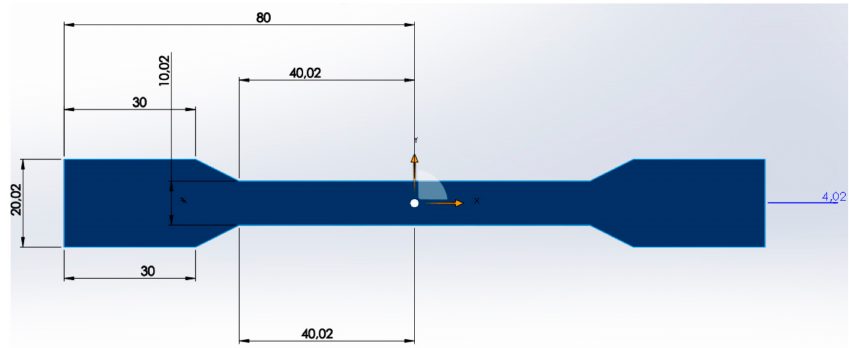
Figure 1. Standard test specimen.